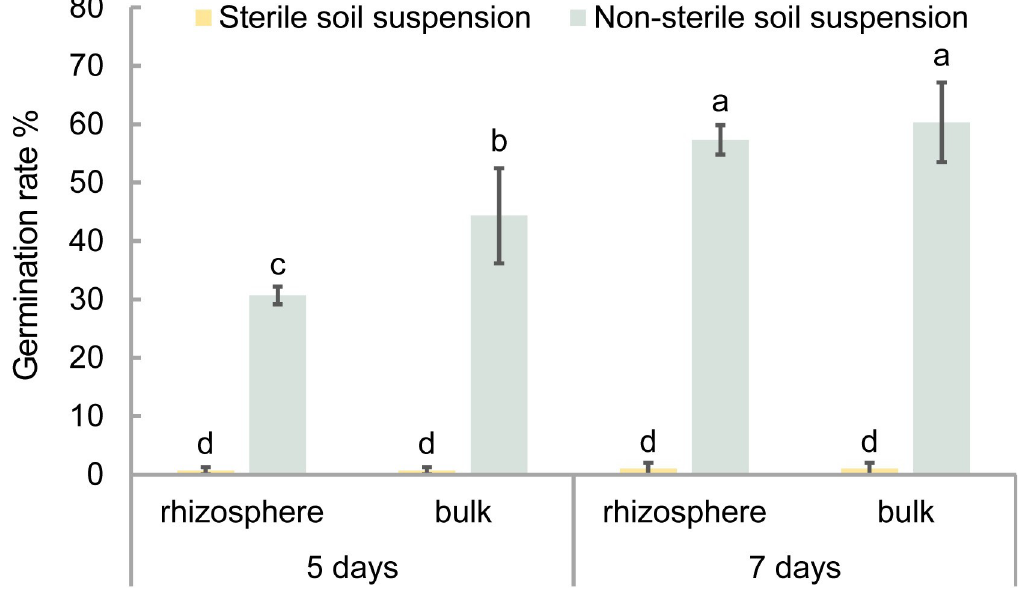
Fig 1. Germination rates of P . brassicae resting spores incubated in non-sterile and sterile soil suspensions from an oilseed rape field after 5 and 7 days of incubation. Rhizosphere soil was collected from the roots of field-grown oilseed rape cv. Bender at BBCH 18 (eight-leaf stage). Bulk soil was collected from a neighbouring field without plants. Error bars represent standard deviations. Different letters represent significant differences among the treatments (Tukey test. P < 0.05, n = 3).